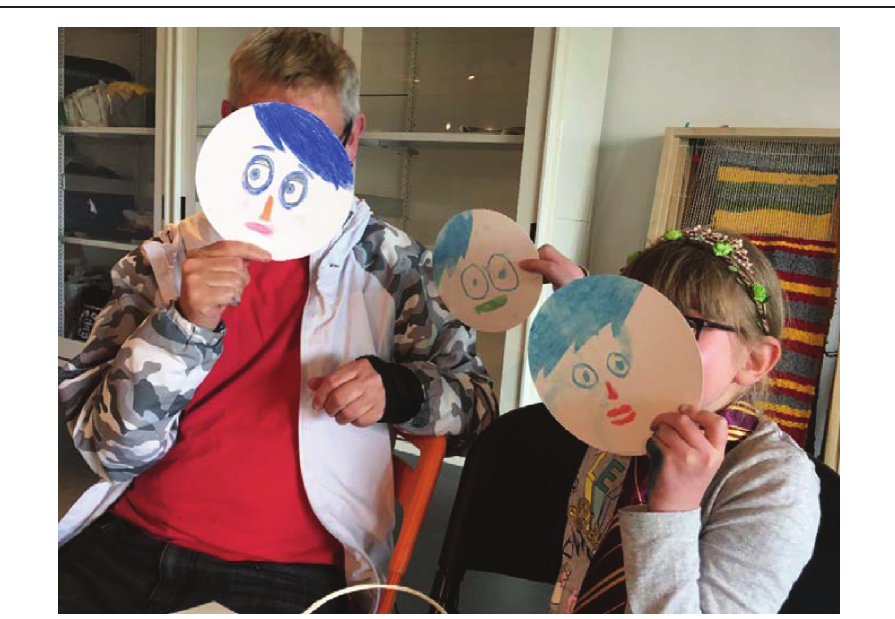
Figure 1: Post-screening activities for My Life as a Courgette at the Middlesbrough Institute of Modern Art